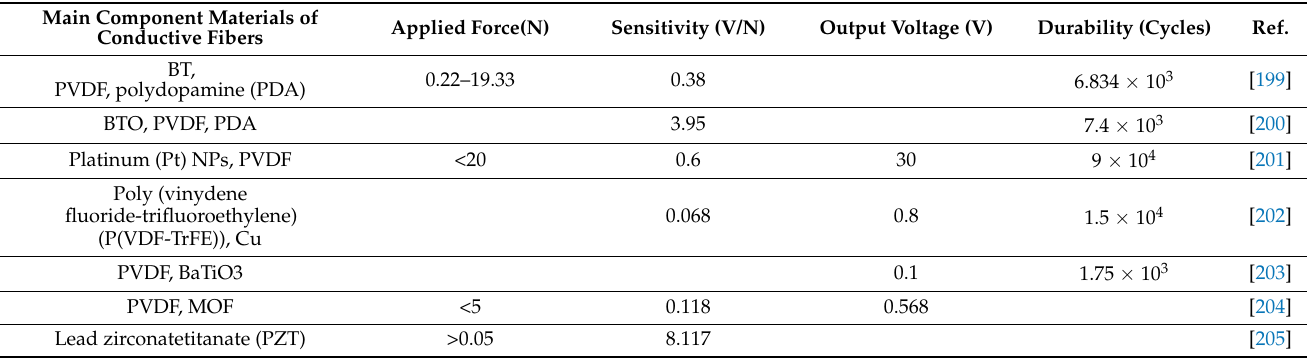
Table 5. Performance data sheets for some piezoelectric pressure